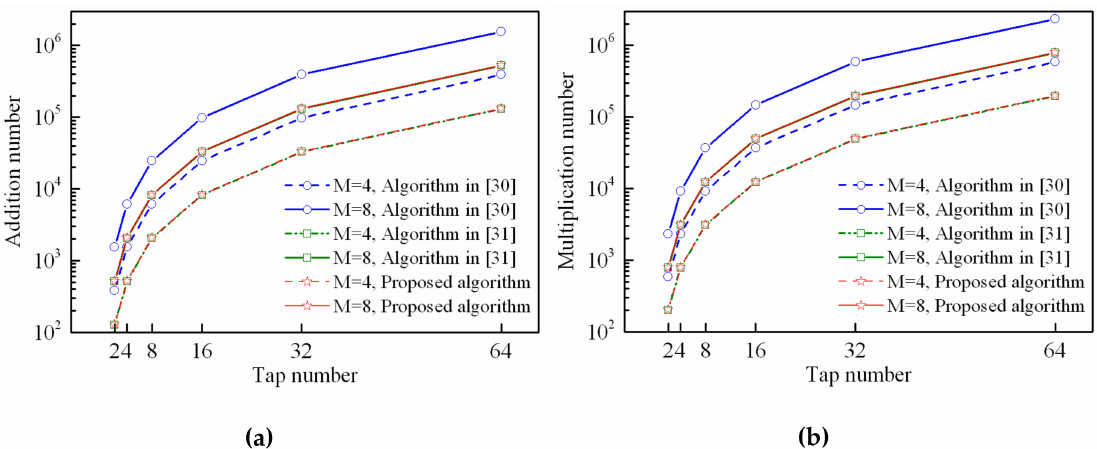
Figure 13. Computational complexity of the proposed STPAP beamforming algorithm and the STPAP algorithms based on the criterions in [30,31] when J = 3: ( a ) addition number; ( b ) multiplication